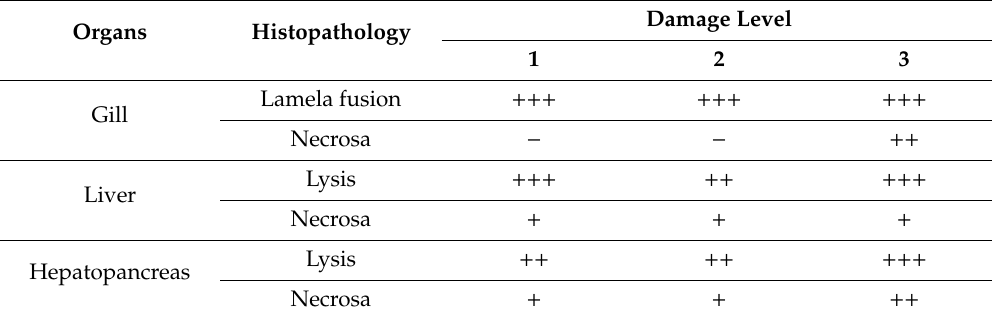
Figure 4. Description of photomicrograph of liver and hepatopancreas of freshwater fish ( Oreochromis niloticus ) after exposure to Hg(II) (20 × 10). Table 3. The level of damage to gill, liver, and hepatopancreas organs after freshwater fish ( Oreochromis niloticus ) exposure to